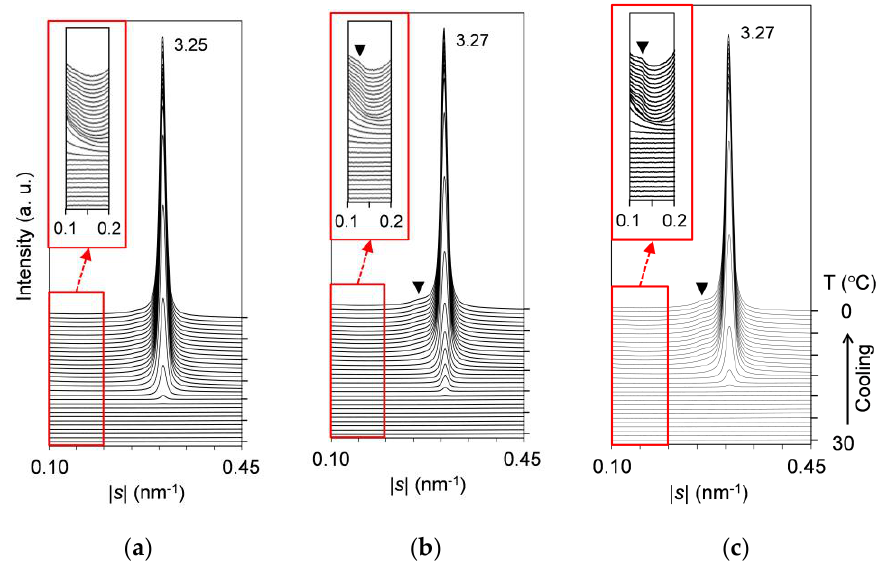
Figure 7. Time-resolved SAXS profiles of SOS / LLL, taken during cooling at a rate of 2 ◦ C / min: ( a ) w LLL = 0.925; ( b ) w LLL = 0.900; and ( c ) w LLL = 0.889. Insets depict the profiles with 50 × magnified intensity. Unit: nm.